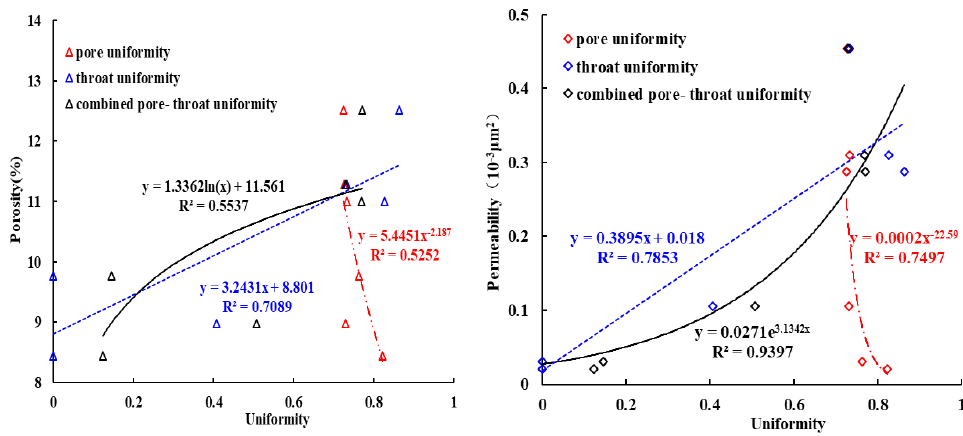
Figure 2. Relationship between reservoir physical properties and pore uniformity, throat uniformity, combined pore-throat uniformity.